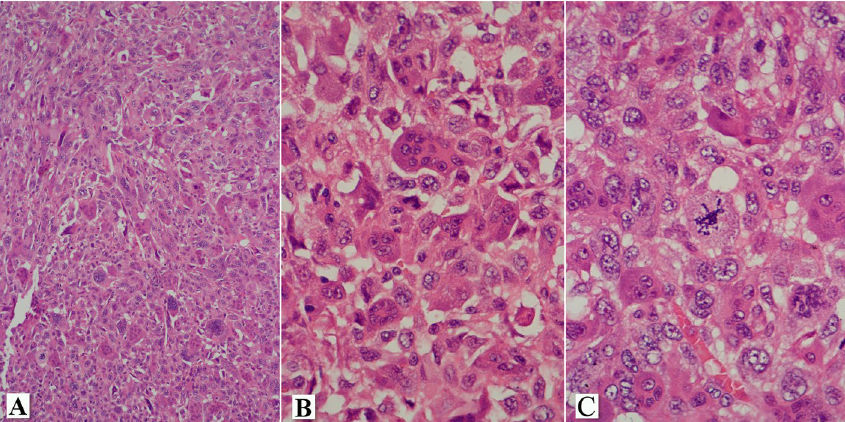
Fig. 2 High-grade sarcoma with numerous non neoplastic osteoclast-type multinucleated giant cells ( A : HE, 10x). It shows brisk mitotic activity ( B : HE, 100x) and frequent atypical mitoses ( C : HE, 400x). The whole tumor was submitted for histological analysis and few areas of equivocal osteoid matrix production were observed ( C : 400x, HE stain). Atypical mononuclear cells show diffuse nuclear staining for SATB2 ( E : 100x and F :400x) while only osteoclast-type multinucleated giant cells stained for marker of histiocytic differentiation, CD68 ( G : 400x)